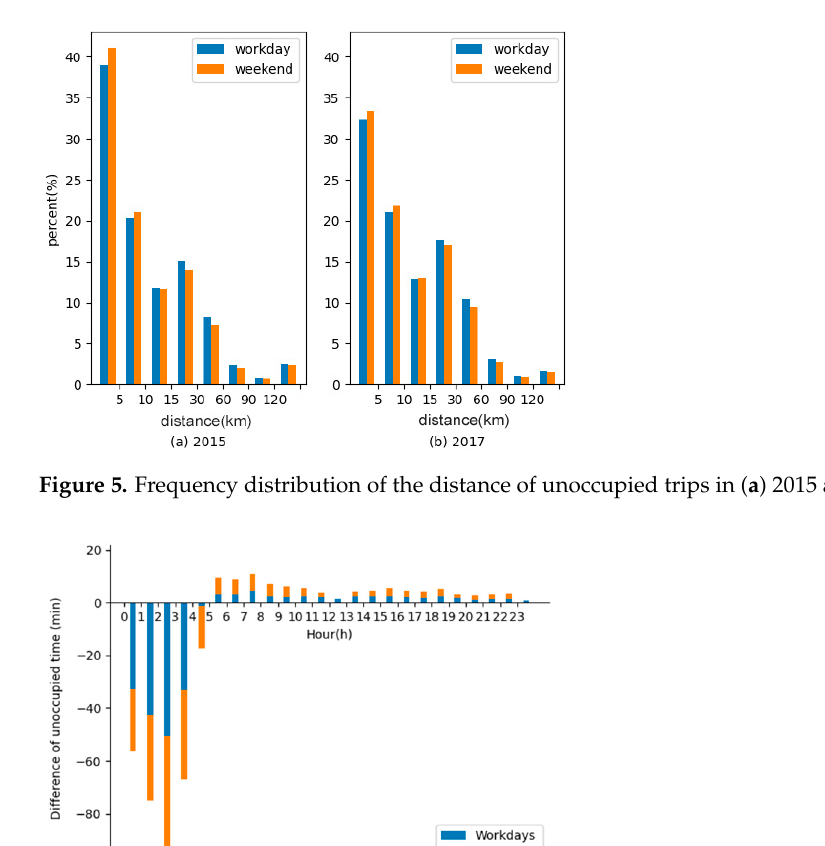
Figure 5. Frequency distribution of the distance of unoccupied trips in ( a ) 2015 and ( b ) 2017.